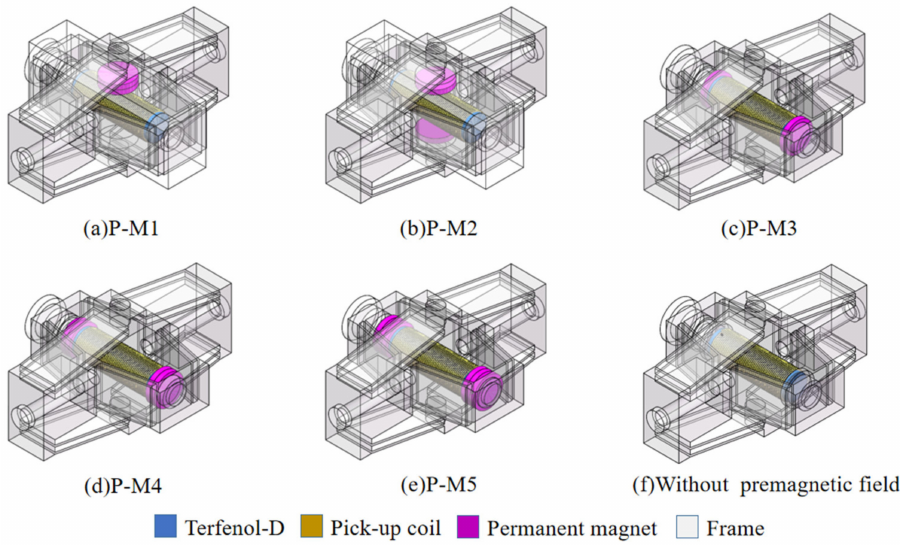
Figure 16. Pre-magnetized magnetic field layout form and control group without pre-magnetization.